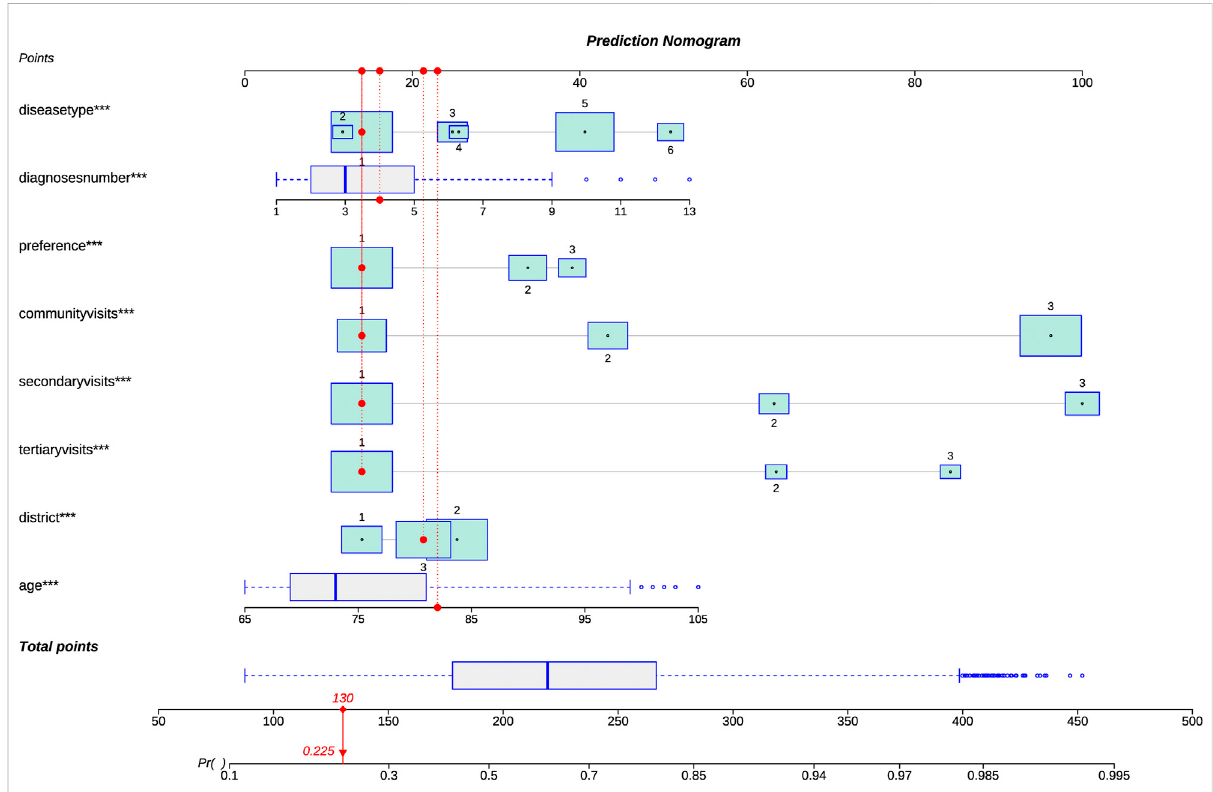
FIGURE 2 Risk prediction model for polypharmacy in the elderly (nomogram). Because there were signi fi cant statistical differences among these eight predictors, we introduced them into the prediction model to establish the polypharmacy risk nomogram, which is used to quantitatively predict the polypharmacy risk probability in the elderly population. For types of living districts, 1 represents countryside, 2 represents suburb, and 3 represents central-city. For the preference for medical institutions, 1 represents community healthcare centers, 2 represents secondary hospitals, and 3representstertiaryhospitals.Forthenumberofvisits,1representslessthanorequalto5,2representsrangingfrom6to10,and3representsgreater than 10. For the main types of disease, 6 represents the respiratory system (J00-J99), 5 represents the circulatory system (I00-I99), 4 represents endocrine, nutritional and metabolic diseases (E00-E90), 3 represents the digestive system (K00-K93), 2 represents themusculoskeletal system and connective tissue (M00-M99) and 1 represents others. For example, by using the nomogram model, it could be concluded that a 82-year-old man, livinginthecentral-cityarea,diagnosedwithfourdiseases,andthemaintypeofdiseasesisnoneofJ00-J99, I00-I99,E00-E90,K00-K93andM00- M99, with the numbers of visits less than or equal to 5 at different levels of medical institutions respectively, with the preference for community healthcare centers, had a 22.5% risk of developing